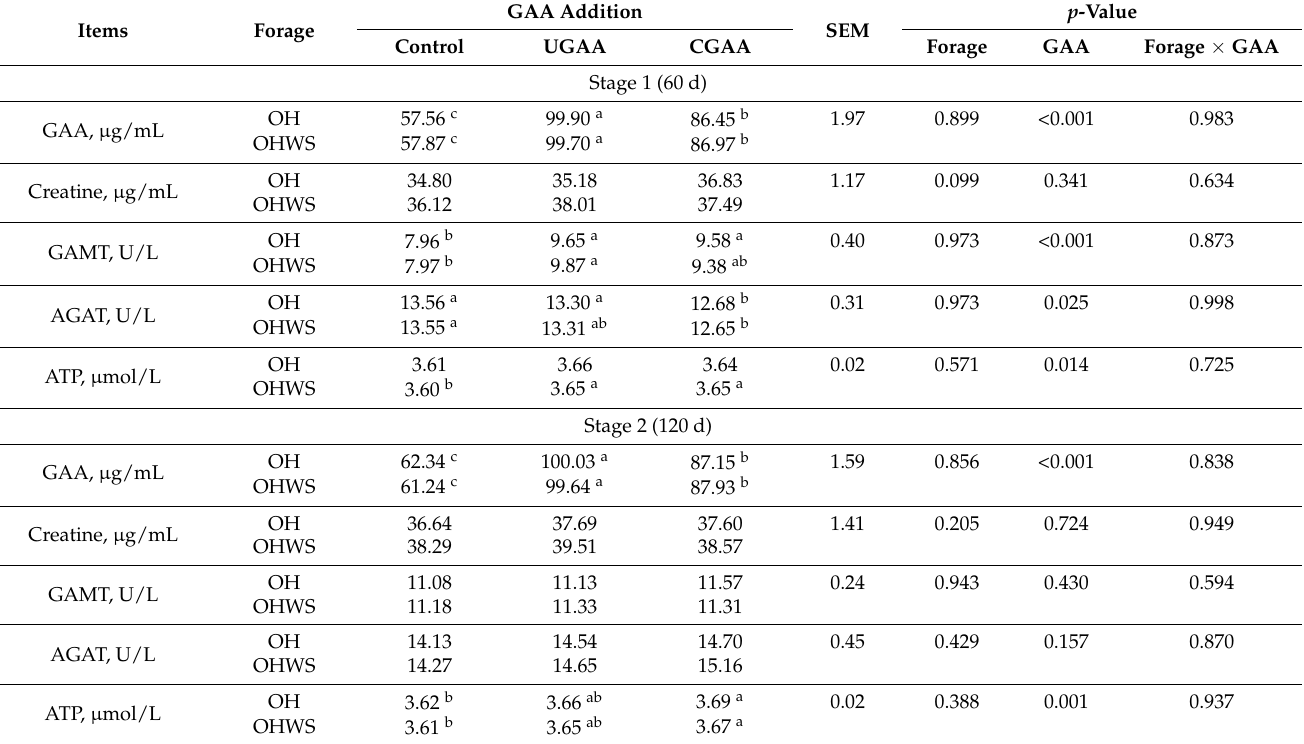
Table 2. Effects of forage type and GAA addition on ruminal GAA, creatine, ATP, and related metabolic